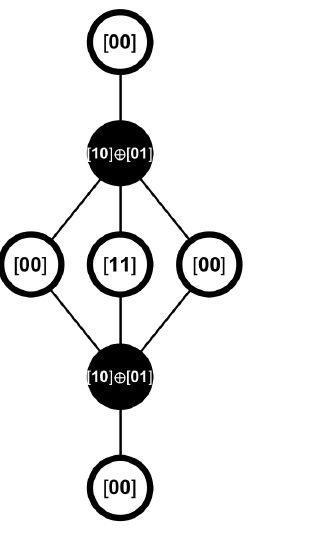
Figure 19 . Adynkra Diagram for 4D mini- mal scalar superfield.